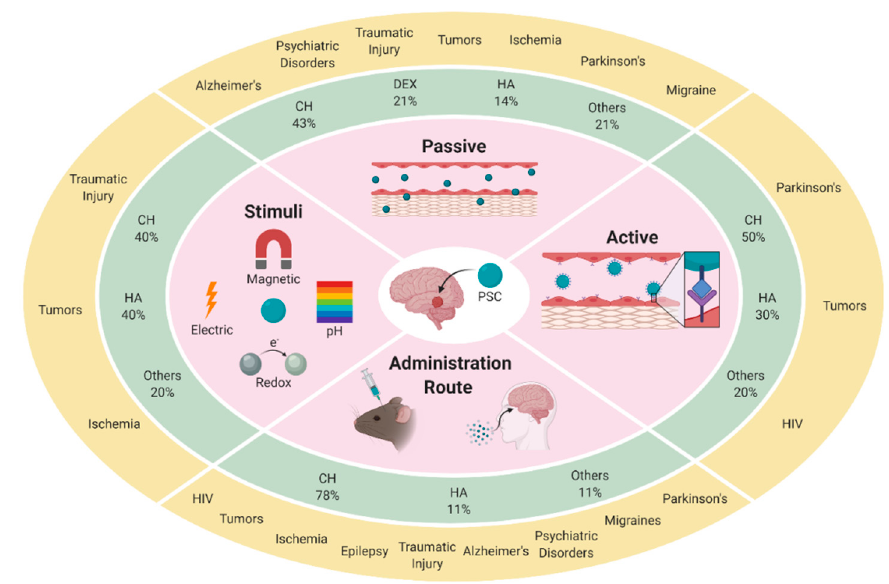
Figure 1. Overview of the main strategies (inner circle) for the vectorization of therapeutic agents to the brain. For each strategy, we report the frequency of use (%) of the different polysaccharide materials (middle circle) in the development of the polysaccharide-containing carriers (PSC) drug delivery systems and their application in the treatment of brain diseases (outer circle). CH: chitosan; DEX: dextran; HA: hyaluronic acid.